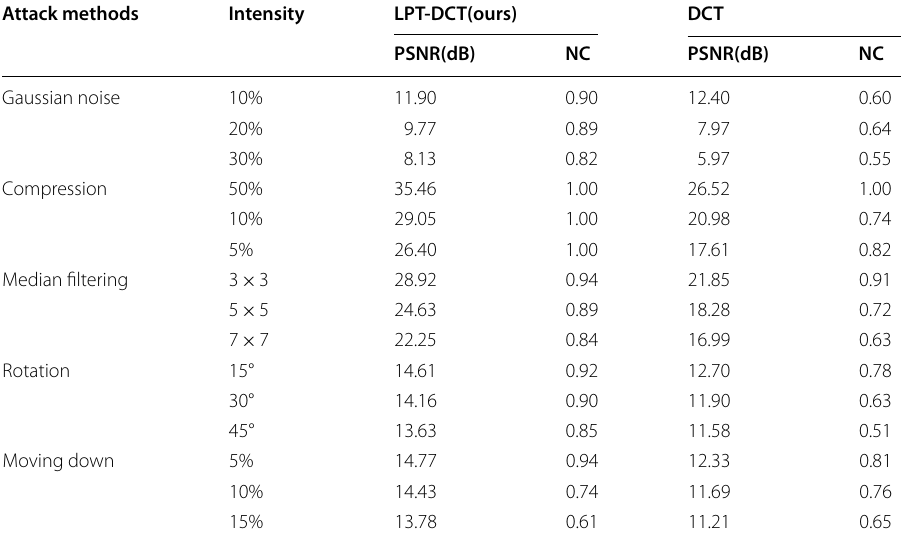
Table 1 Results of different algorithms’ comparison Attack